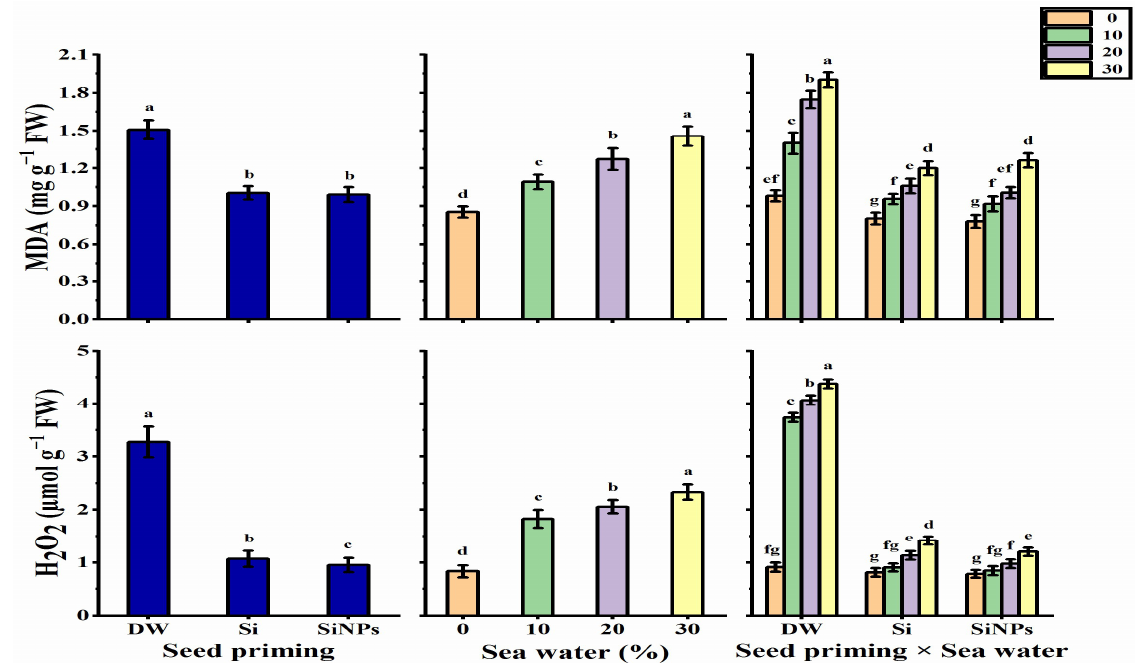
Figure 7. Effect of seed priming on MDA (mg g −1 FW) and H 2 O 2 (μmol g −1 FW) contents of Lathyrus odoratus leaves irrigated with seawater levels (0, 10, 20, and 30%). Data are mean value ± SE. Bars with different letters are significantly different at p ≤ 0.05 level.